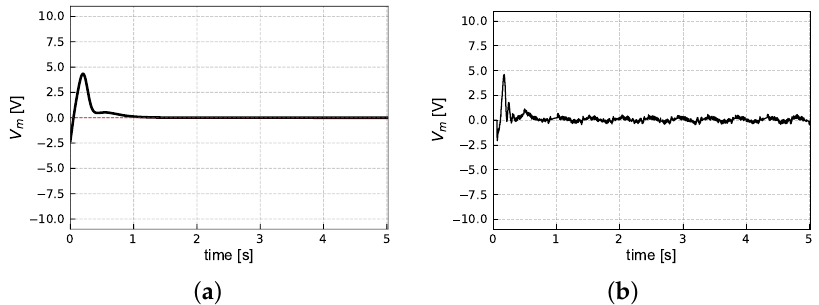
Figure 6. Case A1: Input signal: ( a ) simulation, ( b ) experiment.